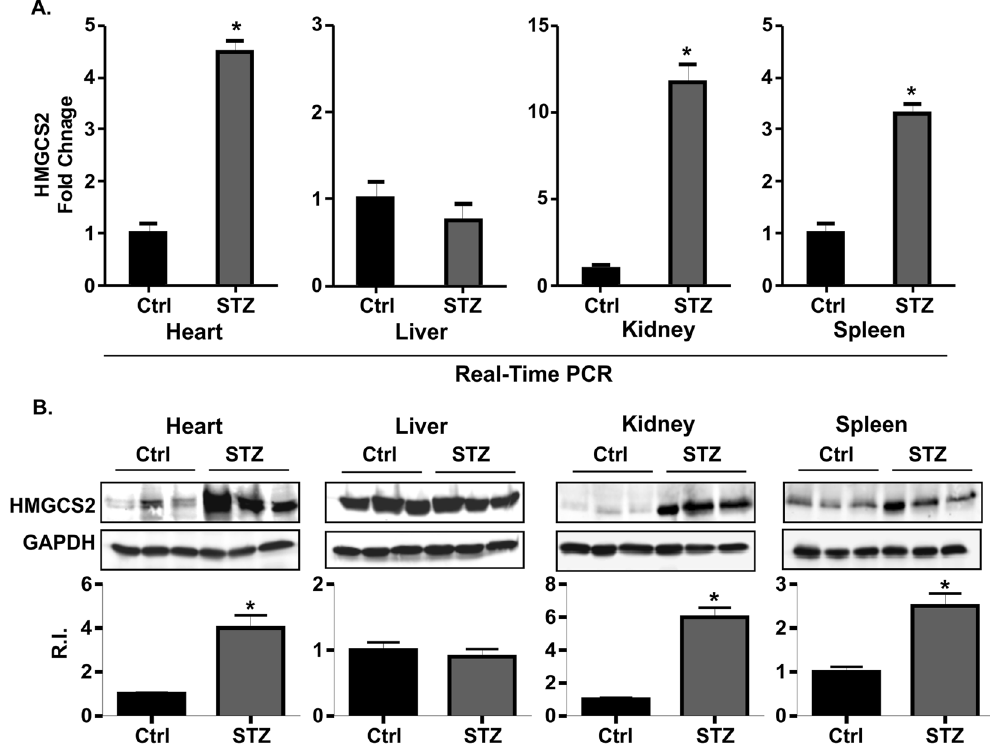
Figure 6. Expression profile of HMGCS2 in different tissues of STZ treated T1D mice with cardiac dysfunction. ( A ) The expression profile of HMGCS2 at mRNA level by real-Time PCR in heart, liver, kidney and spleen. ( B ) The expression profile of HMGCS2 at protein level by western blot in heart, liver, kidney and